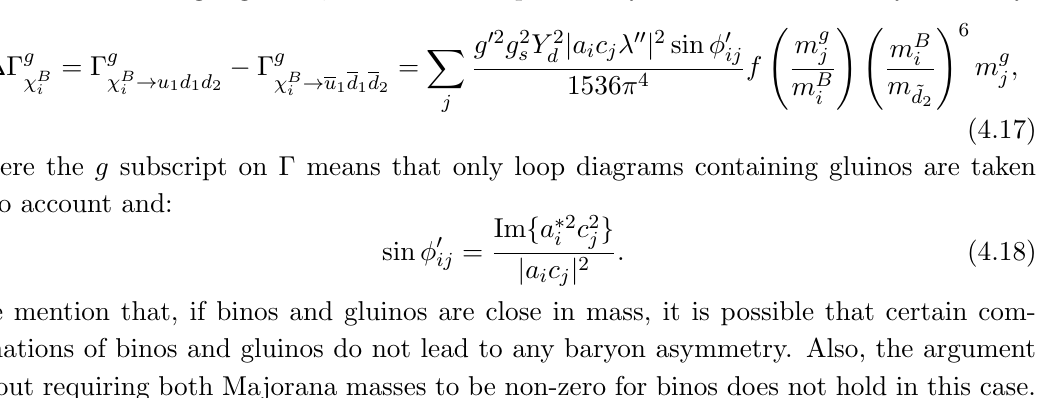
via virtual (cid:31) g i j